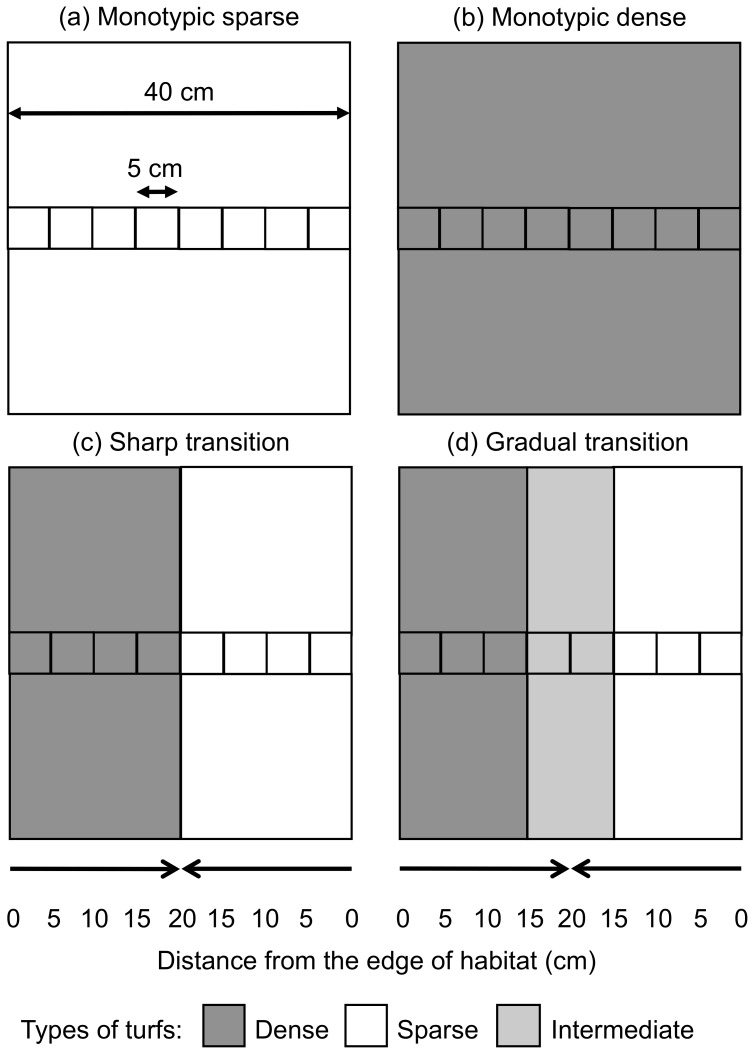
Experimental landscapes of different habitats and with different transitions.(a) Monotypic sparse and (b) monotypic dense; (c) sharp transition between dense and sparse and (d) gradual transition between dense and sparse. The smaller squares in that run across the experimental landscapes represent eight 5×5 cm pieces of artificial turf that were sampled. The final shape of the experimental landscapes was rectangular (40×45 cm; see Fig. 1) to ensure that all eight samples had the same distance to the remaining edges of the landscape (i.e. 20 cm). The area of experimental landscapes was 1800 cm2.